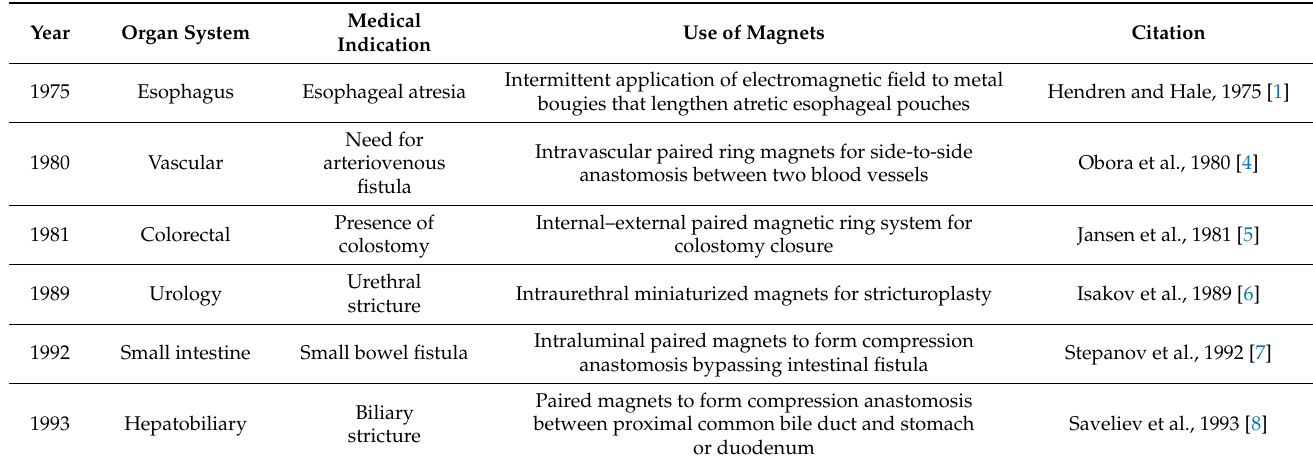
Table 1. Historical in-human application of magnets in